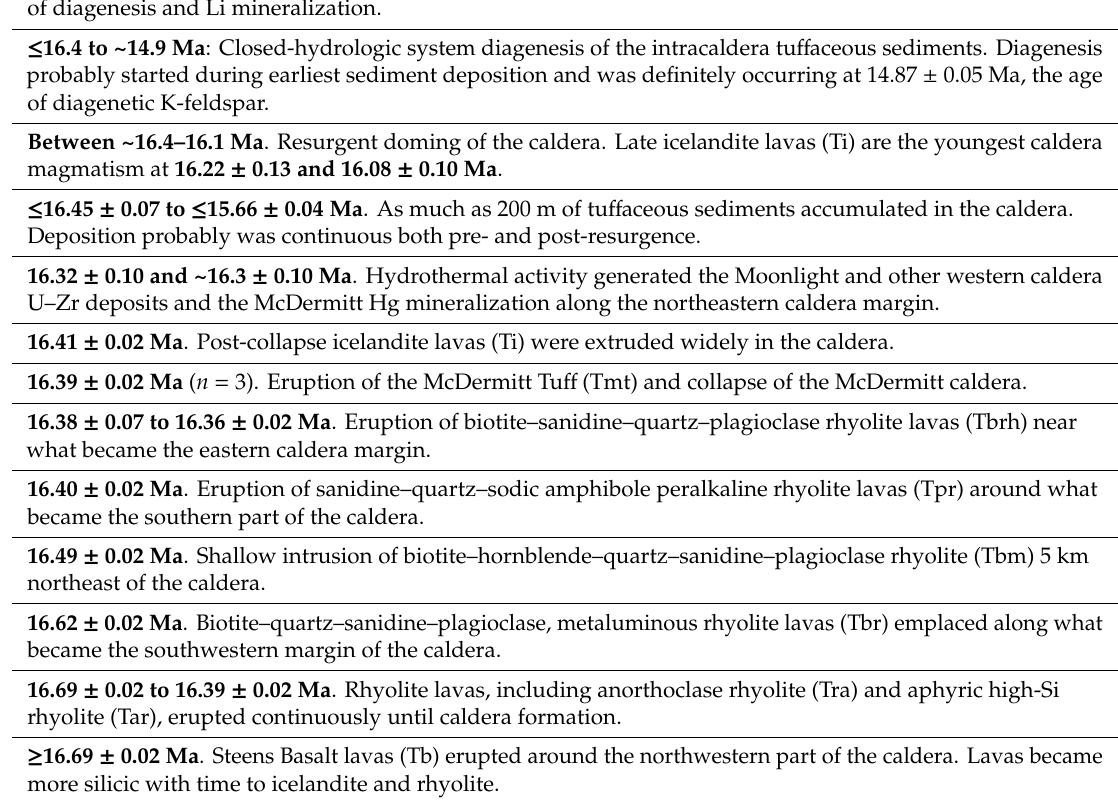
Table 1. McDermitt Caldera: major volcanic, hydrothermal, and diagenetic